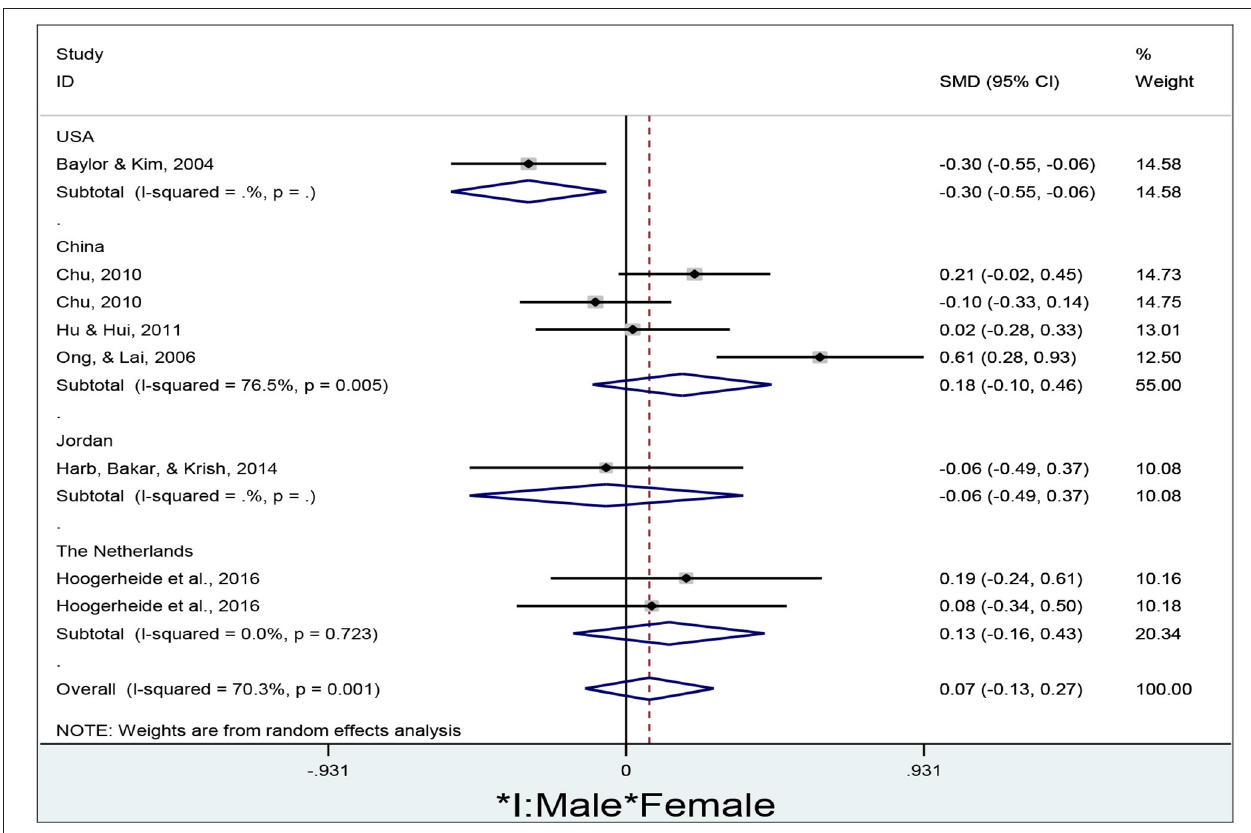
FIGURE 5 | Gender differences in e-learners’ self-efficacy in different countries.